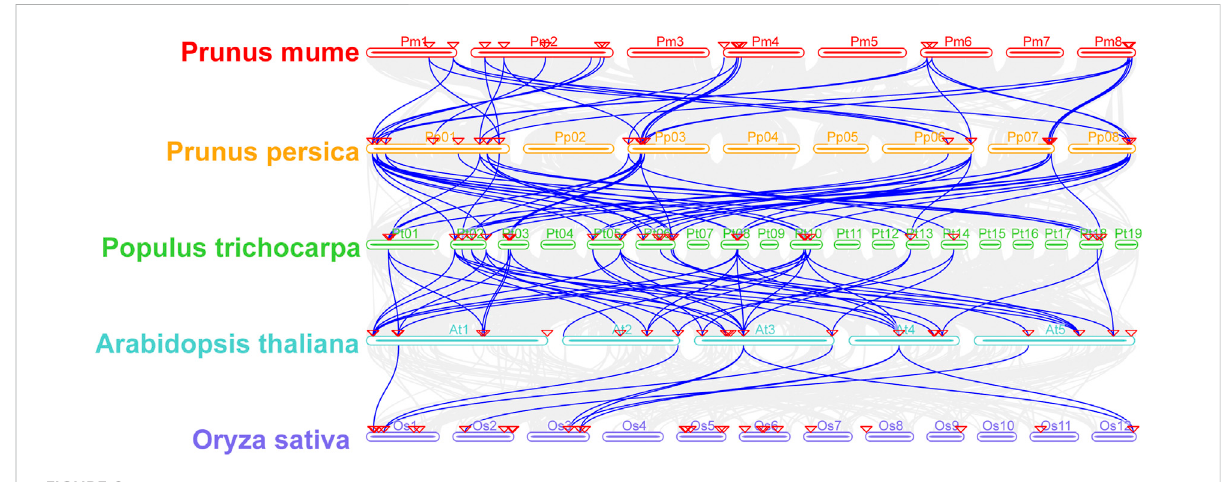
FIGURE 8 ThesyntenyanalysisofIAAgenesfrommei,Arabidopsis,peach,poplar,andrice.Thegraylinesinthebackgroundrepresentthecollinearblocks among fi ve species, the blue lines emphasize the syntenic Aux/IAA gene pairs and the red triangle represents Aux/IAA